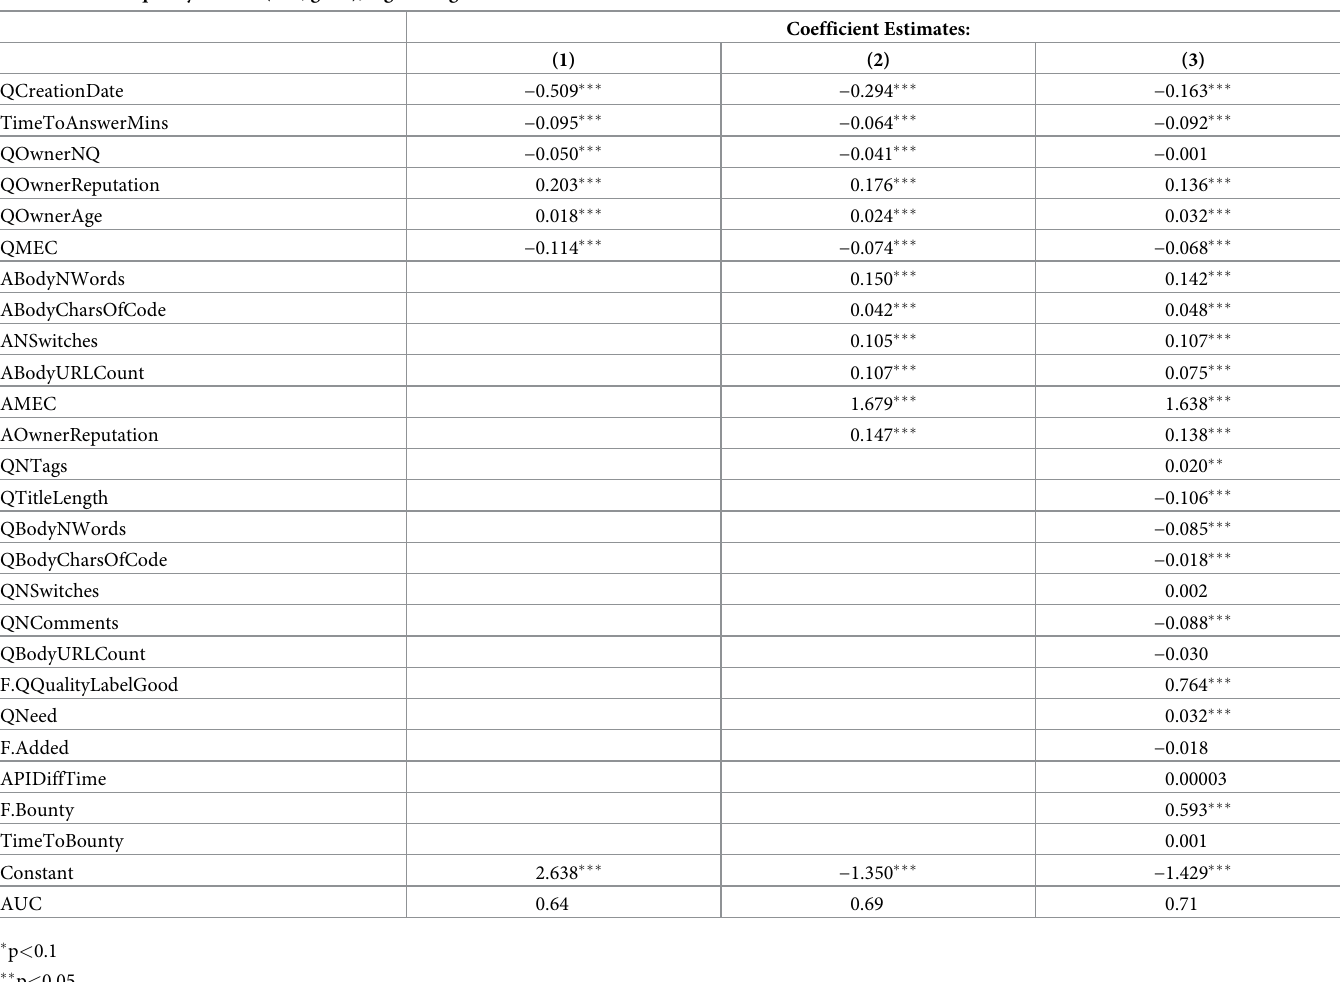
Table 6. Answer quality models (bad, good), logistic